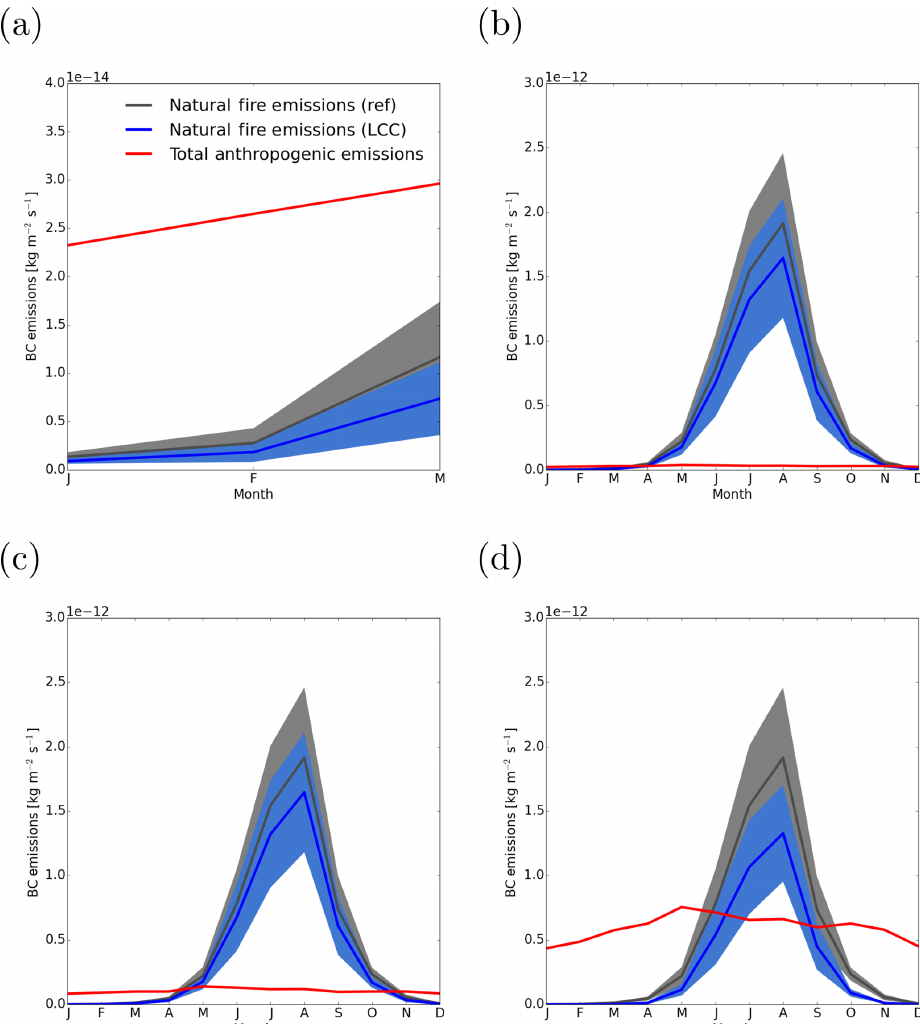
Figure 4. Monthly averaged BC emissions in our study domain for (a) the beginning of the year and (b) – (d) the whole year. The shadings show the standard deviation for each month over the 20-year period since our natural fire emissions have interannual variability. The grey line shows the natural fire emissions of the simulations no_human, LCC_HYDE, and LCC_KK, whereas the blue line shows the natural fire emissions of the simulations LCC_HYDE_low, LCC_HYDE_int, and LCC_KK_high, in which anthropogenic land cover change reduces the natural fire emissions. The red line shows the total anthropogenic aerosol emissions. In (a) and (b) , the BC emissions from the low scenario are shown; note that the y scale is smaller in (a) than in the other subfigures. In (c) and (d) , the emissions from the intermediate and high scenarios are shown,